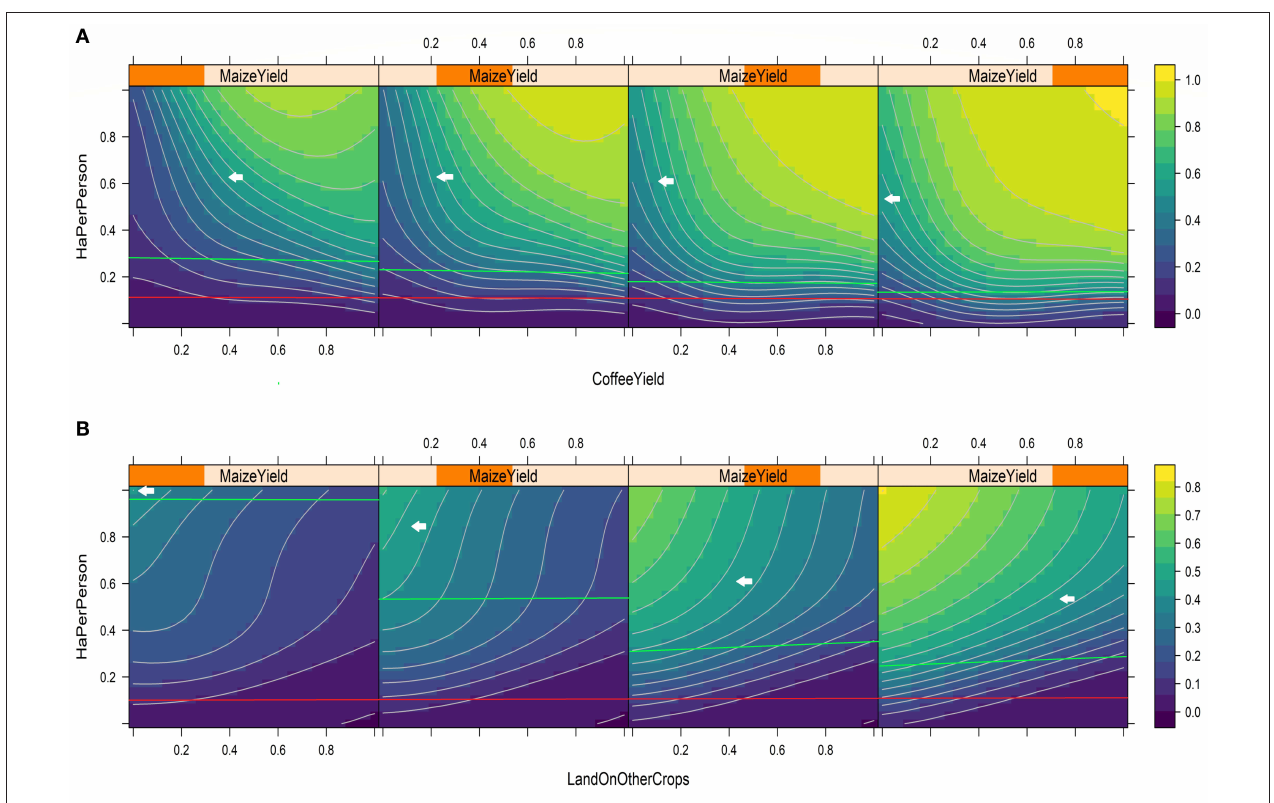
FIGURE 6 | Partial dependency plots of three simultaneous variables. (A) Hectares per person - Coffee Yield - Maize Yield. (B) Hectares per person - Land Under Other Crops-Maize Yield. Contour curves show the regions of the values of scaled PFA. A second and third variable are represented on bottom and top edges respectively of each plot, the orange rectangle shows the quartile of the third variable that are plotted on each panel, from left to right. Arrows point to the contour line that is equivalent to a PFA interval between 2300 and 2740 kcal/day per MAE. Red line represents the average sample land availability (0.13 ha per person) and the green lines represent the land availability necessary to reach the 2300 and 2740 kcal/day per MAE